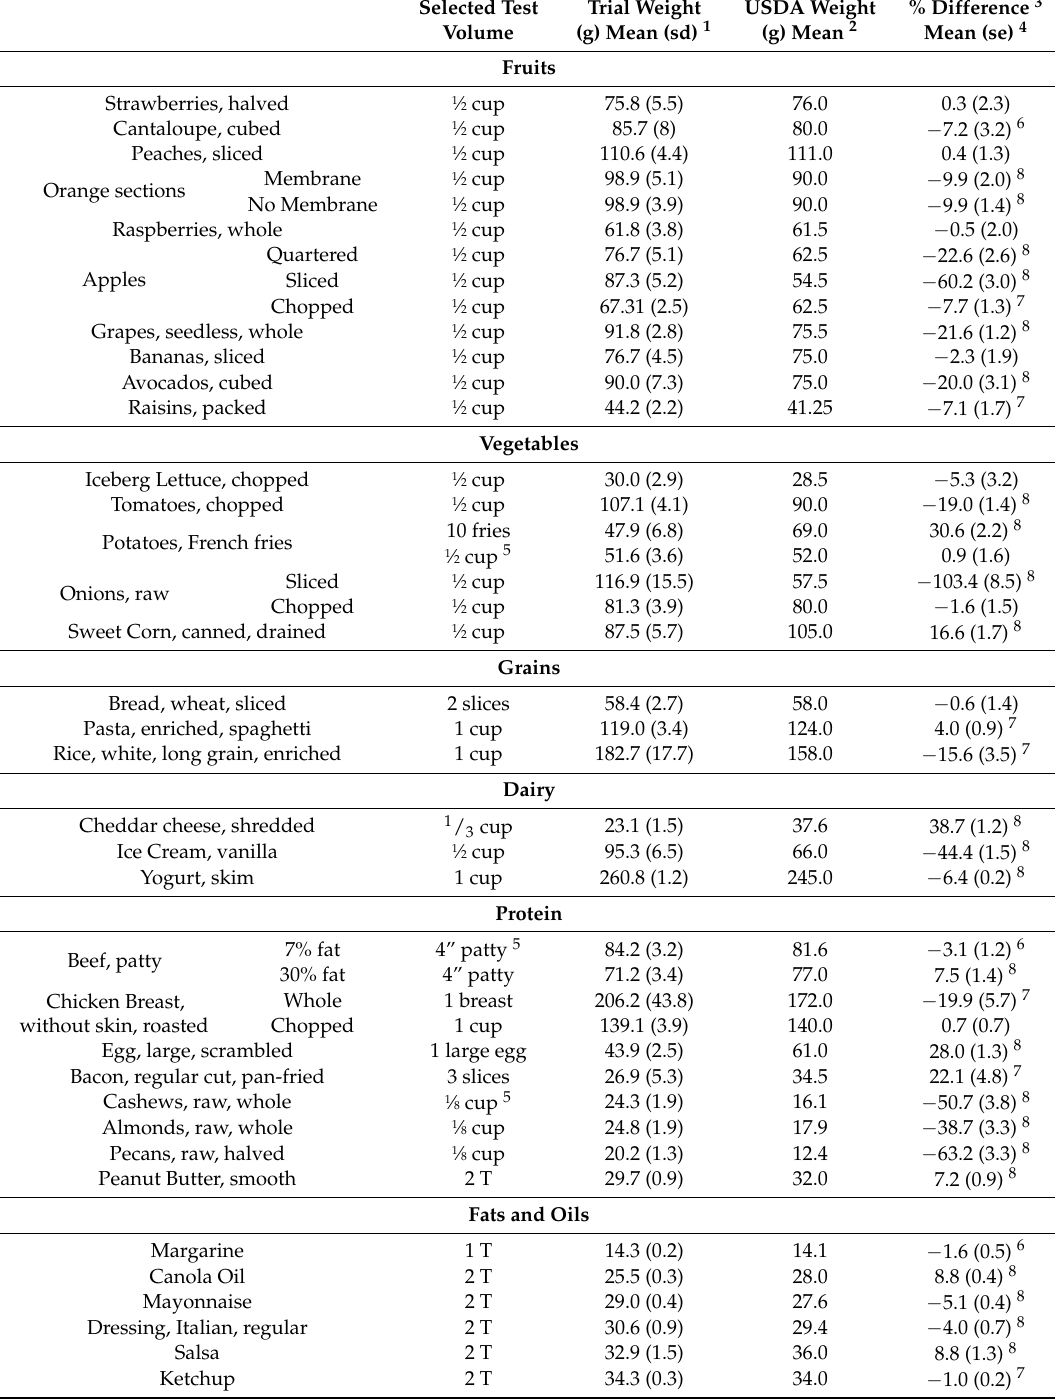
Table 2. Comparison of mean measured (trial) weights of individual foods to the USDA-SR (United States Department of Agriculture National Nutrient Database for Standard Reference) 28 database weight for selected food